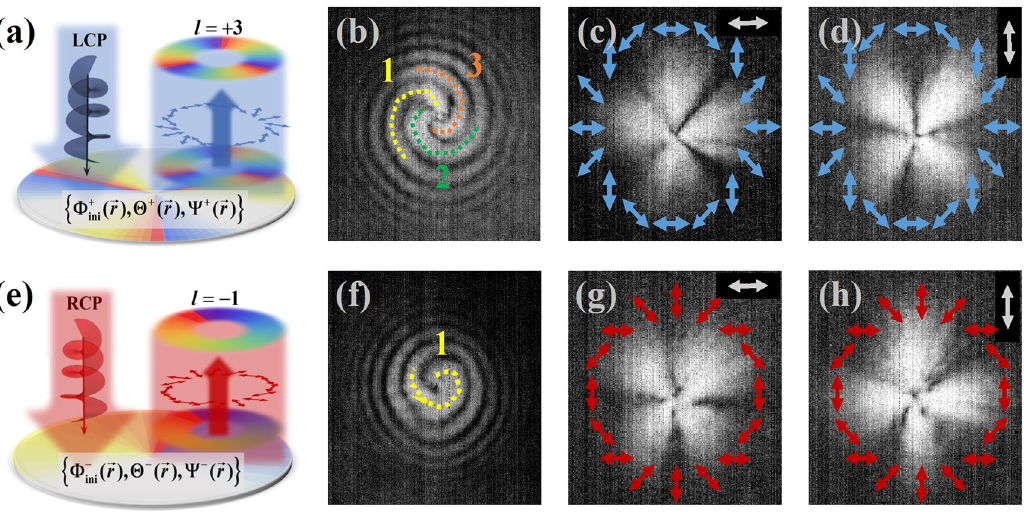
Figure 6: Experimental characterizations of metadevice II. , Θ + , Ψ + } and { Φ − , Θ − , Ψ − } distributions as given by Eqs. (9) and (10), under Schematics of light scatterings at a metadevice exhibiting { Φ + ini ini illuminations of (a) left circular polarization (LCP) and (e) right circular polarization (RCP) incidences. Measured far- fi eld interference patterns betweenasphericalreferencewaveandlightbeamsre fl ectedbymetadeviceIIunder(b)LCPand(f)RCPincidences,respectively.Far- fi eldimages recordedbyourCCDwithalinearpolarizerplacedinfrontof it,tiltedbyanangleof (c,g)0 ° and(d,h)90 ° ,asmetadeviceIIisilluminatedby(c,d) LCP and (g, h) RCP incidences, respectively. Arrows in (c, d, g, h) illustrate the expected polarization patterns at different